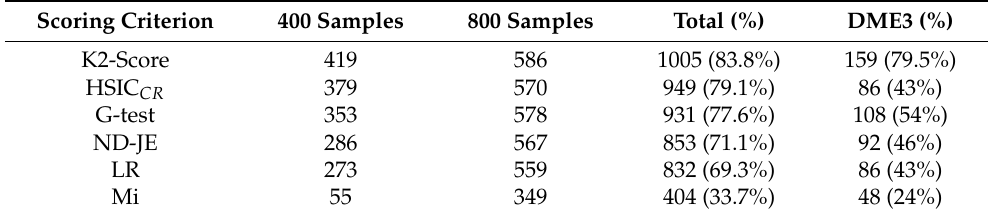
Table 2. The number of times, out of 600 data sets generated by six models with marginal effects, where k = 2, that each scoring criterion identified epistasis SNPs of snp1000 for sample sizes of 400 and 800. The fourth column gives the total accuracy over all sample sizes. The last column gives the accuracy over all sample sizes in the most difficult model. The scoring criteria are listed in descending order of total